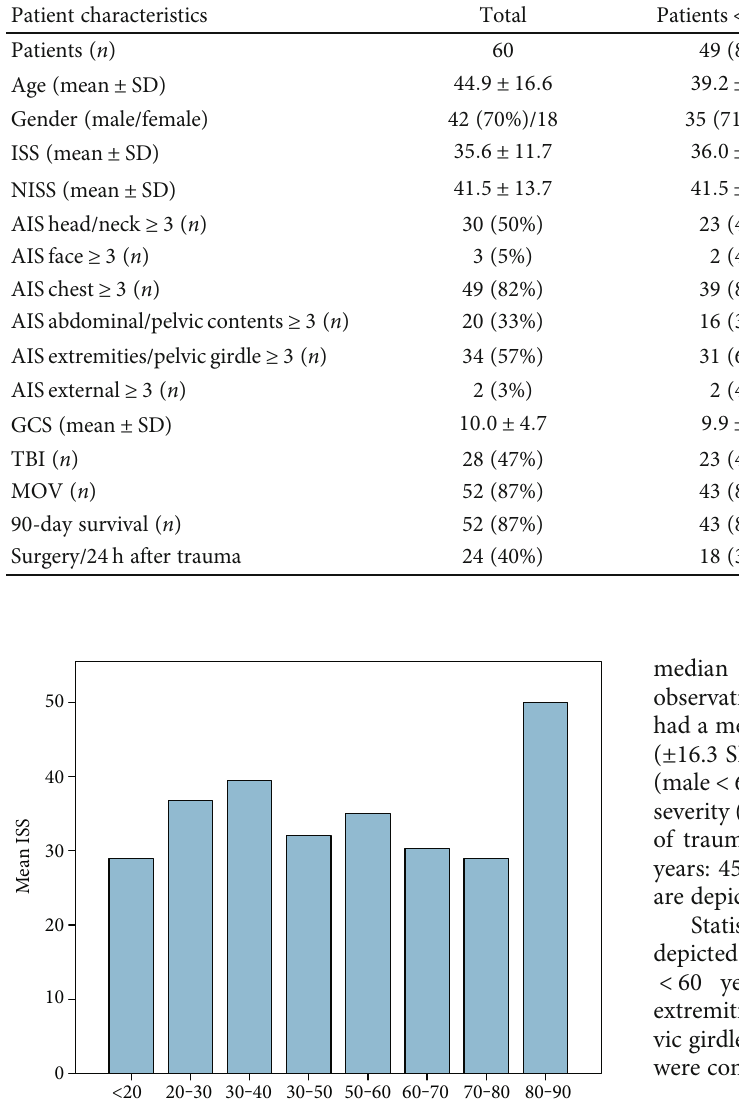
Table 1: Statistical analysis of patients ’ characteristics (Mann-Whitney U -test, chi square; p < 0 : 05 ).